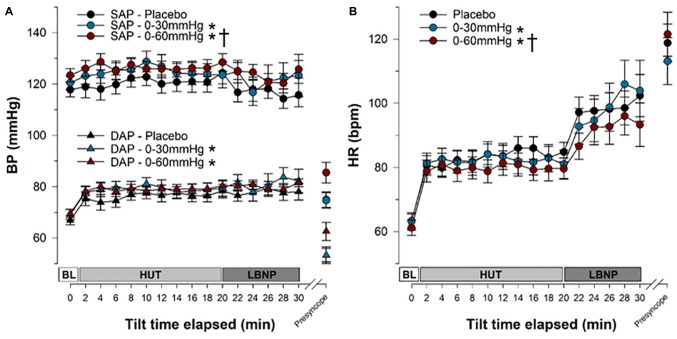
Blood pressure and heart rate responses during tilt testing. The time course of blood pressure (A) and heart rate (B) during tilt are shown. Symbols (mean ± SEM) reflect averaged data, over the last 30 s of every 2 min interval. Main effects of condition throughout tilt are shown. ∗Significantly different from placebo (p < 0.001); †Significantly different from 0 to 30 mmHg compression. BP, blood pressure; SAP, systolic arterial pressure; DAP, diastolic arterial pressure; HR, heart rate; BL, baseline; HUT, head-upright tilt; LBNP, lower body negative pressure.